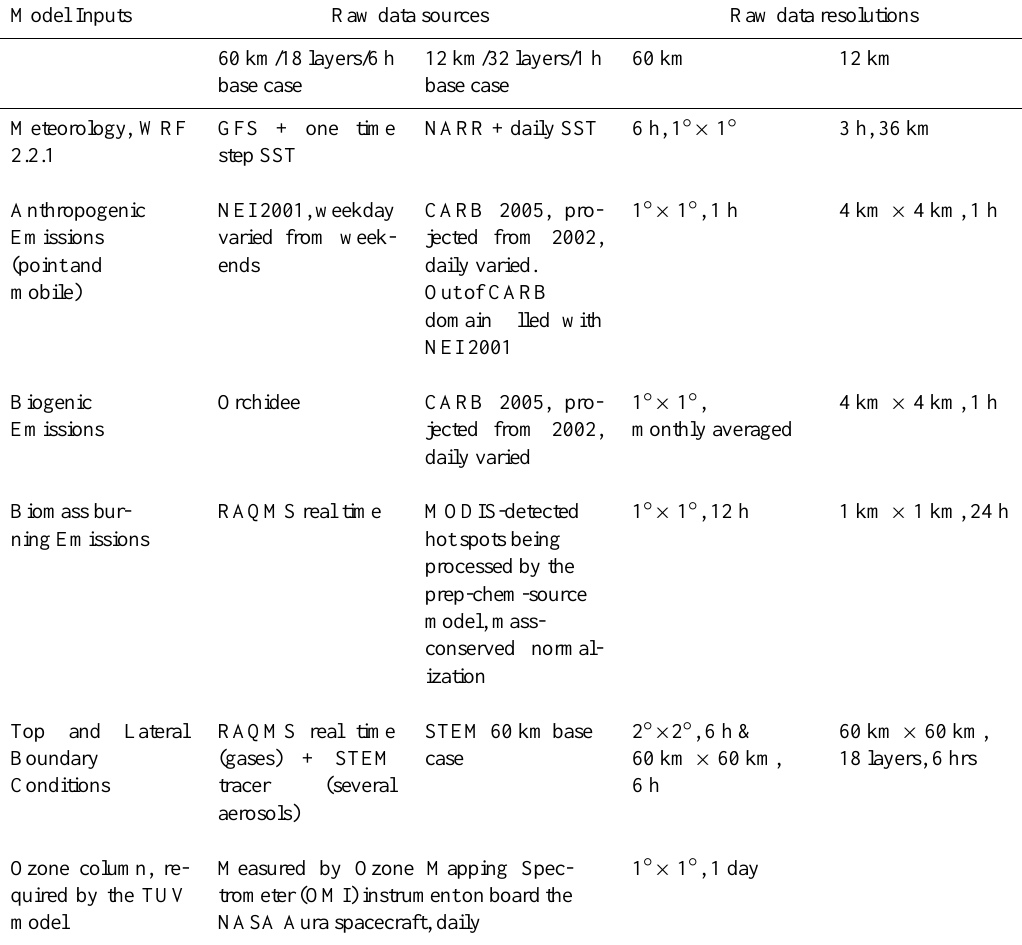
Table 1. Summary of STEM inputs for base cases in two